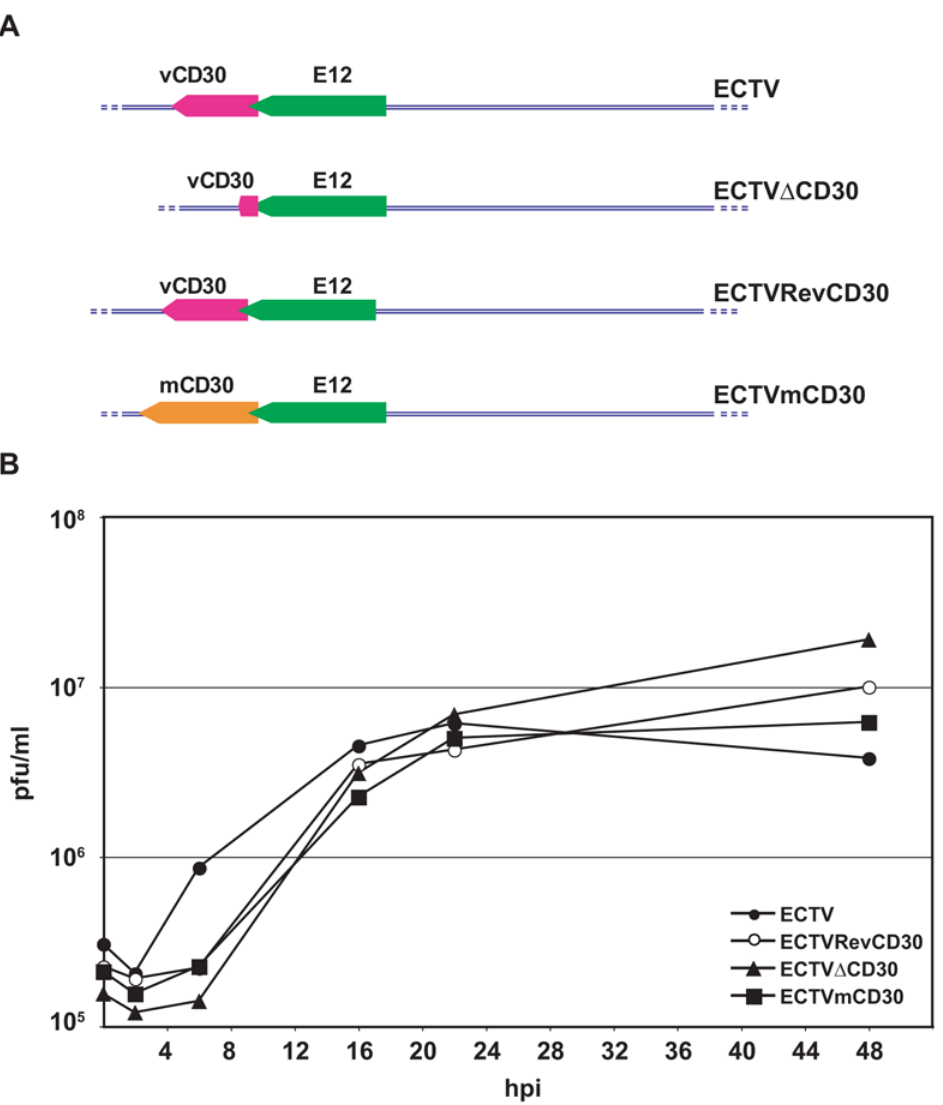
Figure 2. ECTV vCD30 is not essential for virus growth in cell culture. A. Representation of the genomic structure of the different ECTV generated showing the vCD30 and the adjacent E12 loci. B. Single-step growth curves of the indicated viruses on BSC-1 cells. Shown are means of triplicate samples for each time point.